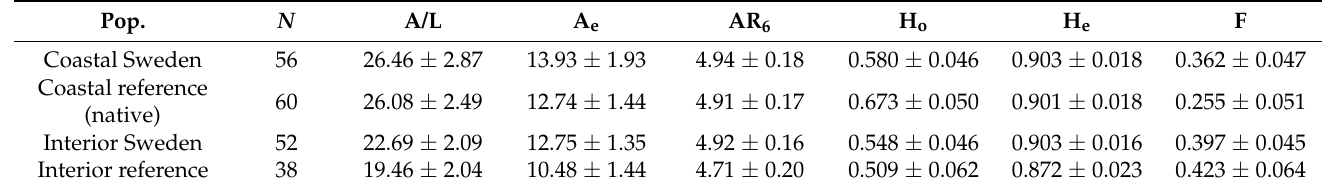
Table 4. Average ± standard error of various diversity measures for Swedish and native Douglas fir (reference populations) assigned to one of the two varieties by STRUCTURE for K = 2. A/L = number of alleles per locus, A e = effective number of alleles, AR 6 = allelic richness; rarefaction size = 6 alleles, H o = observed heterozygosity, H e = expected heterozygosity, F = fixation index. Pop.